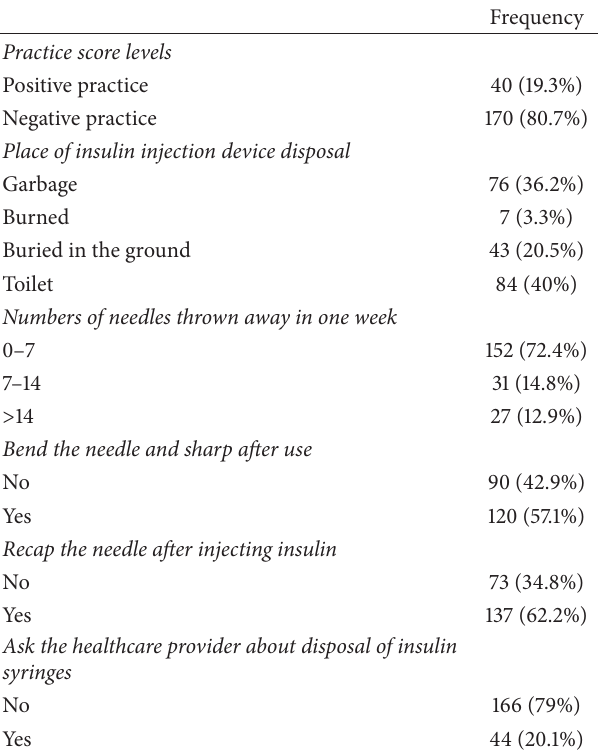
Table 4: Respondents’ practices regarding insulin injection device waste disposal ( 𝑛 = 210